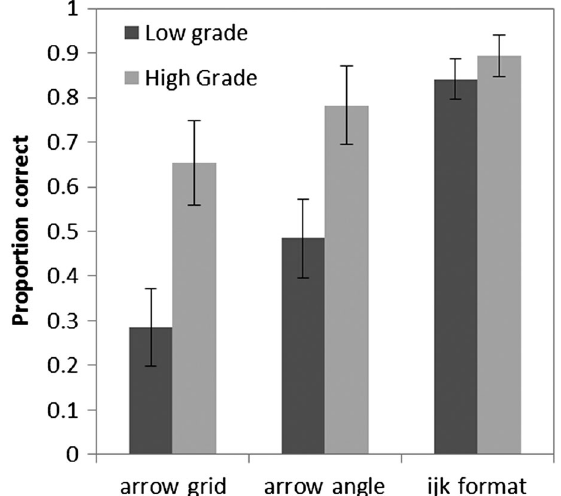
FIG. 9. Student performance ( N ¼ 221 ) on two-dimensional physics context question (Fig. 6) separated by student grades above or below the median course grade (high grade or low grade). Error bars indicate (cid:2) 1 SE.